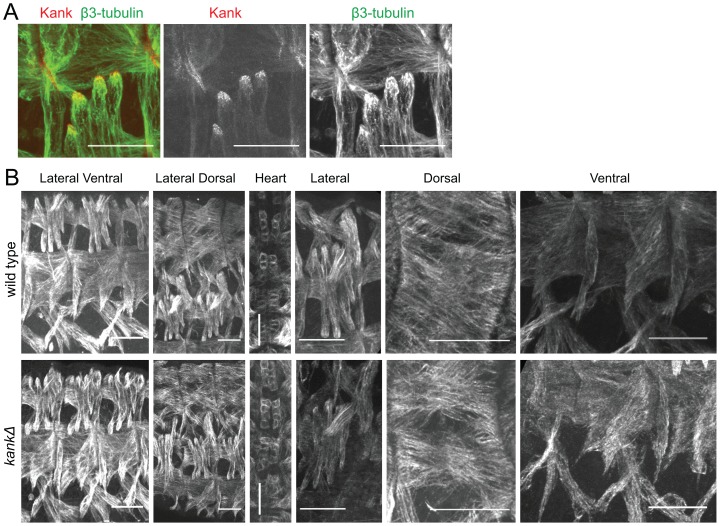
Deletion of kank did not affect muscle cell morphology or microtubule organisation.(A) Closer examination of the lateral transverse muscle shows Kank staining near sites where microtubule ends are attached to the periphery of muscle cells. (B) No clear differences were seen in the overall organisation of somatic musculature, or in the organisation of their microtubules, between wild type and kankΔ as imaged with β3-tubulin staining. Scale bars = 25 µm.